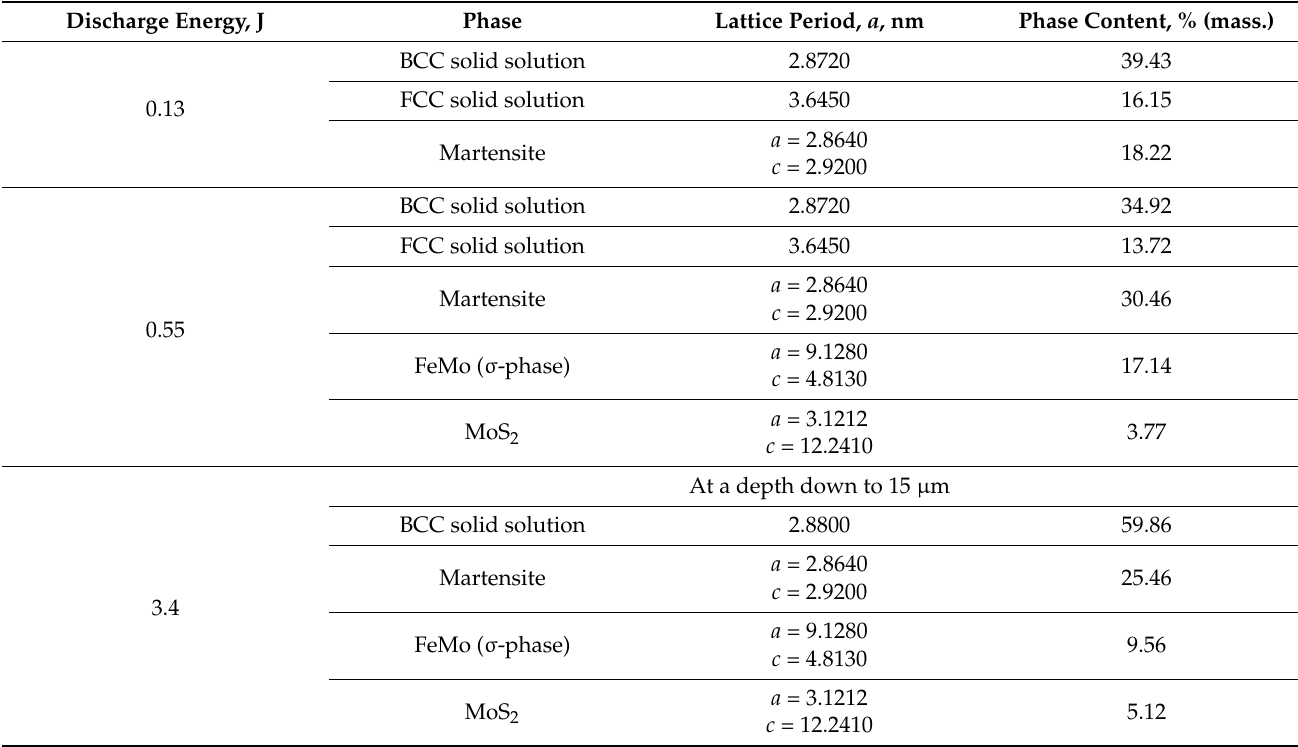
Table 4. Parameters for crystal lattices of phases and quantitative phase analysis of the sulfomolybdenum coatings on C22 steel. Discharge Energy,